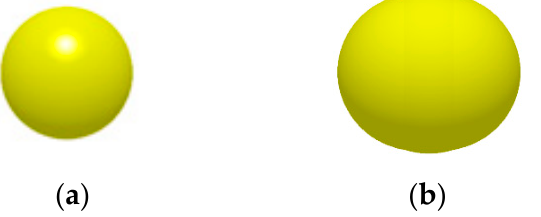
Figure 7. Simulation model of soil and tiger nut particle: ( a ) Soil particle; and ( b ) tiger nut particle. The parameters of the simulation model consist of intrinsic parameters and contact parameters of the aggregates. The intrinsic parameters of the aggregates could be deter- mined via bench-scale testing, while contact parameters were calibrated by combining bench-scale testing and simulation experiments to further improve the reliability of discrete element simulation experiments [25]. The parameters for the contact between tiger nuts and steel plates, and the contact between tiger nuts, could be determined by calibration; other parameters are determined by referring to literature [26–30]. Q235 steel was used as geometry material. The simulation test parameters of tiger nuts are shown in Table 2. Table 2. Simulation test parameters of tiger